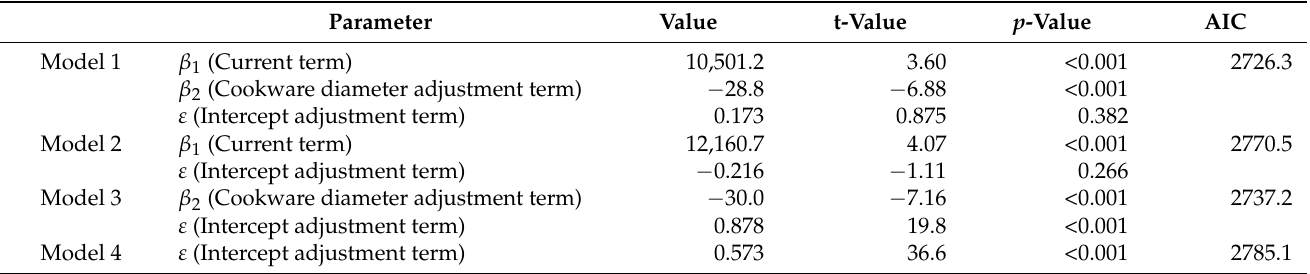
Table 2. Coefficients of the calculated estimation equations.